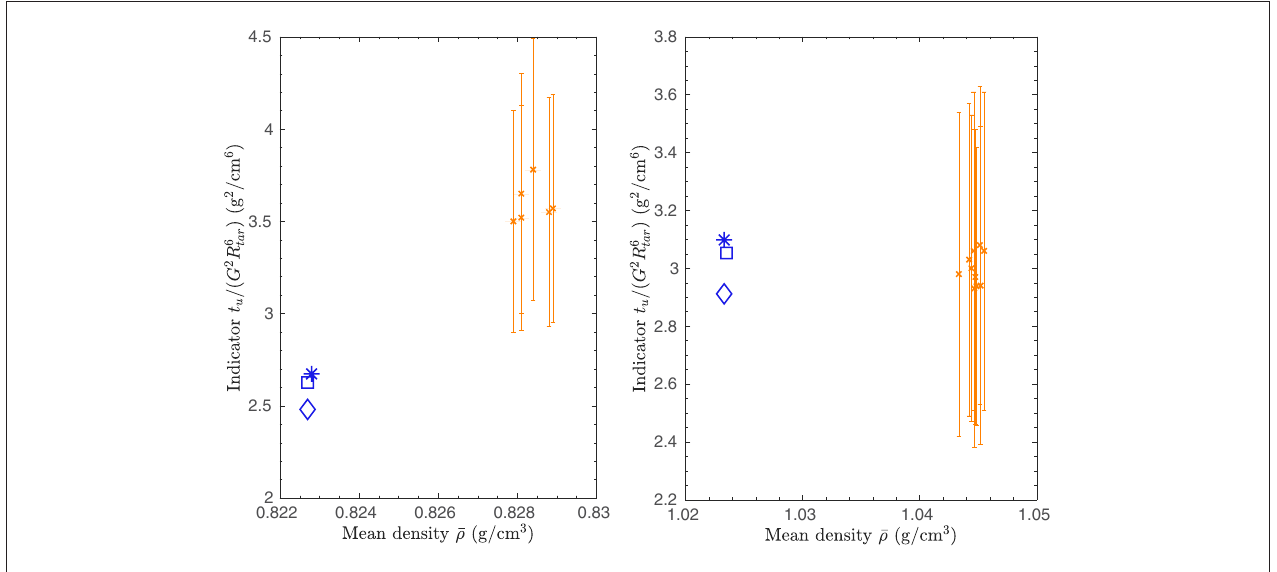
FIGURE 13 | Comparison of t u and ¯ ρ inversions for 16CygA and B for the models considered in this study. The blue symbols refer to the reference models: ∗ for the standard models, (cid:3) for the models with modified opacity and ♦ for the models including both the opacity modification and turbulent diffusion.